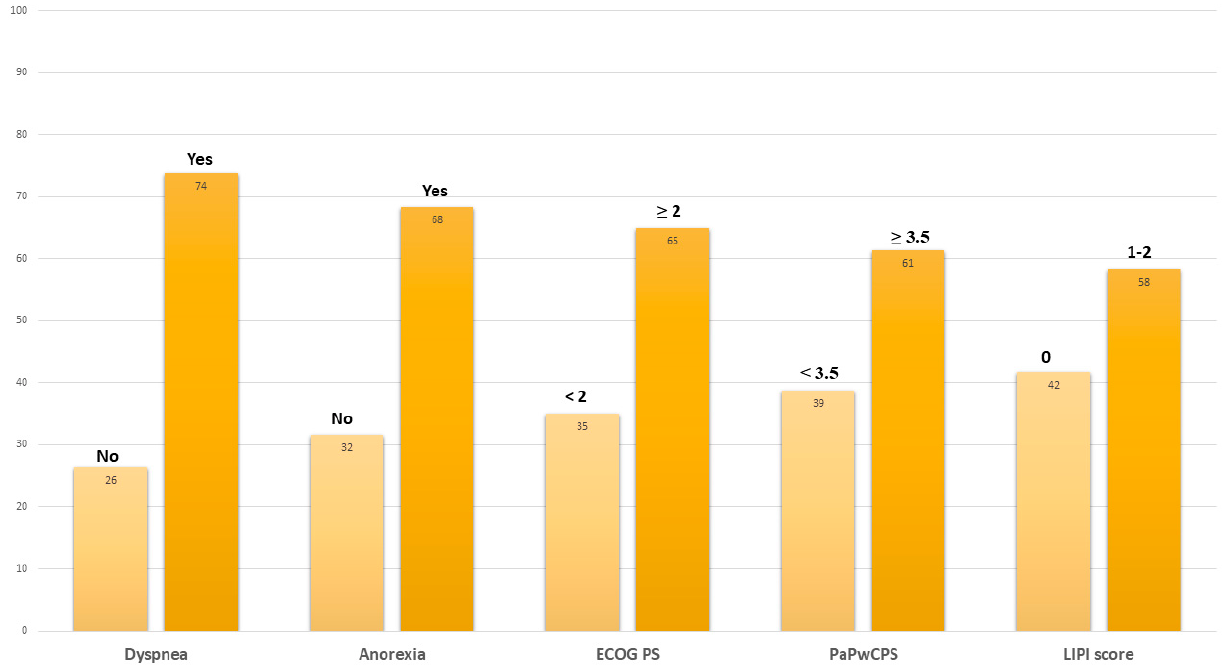
Figure 1. Clinical characteristics registered at last immunotherapy cycle. Abbreviations: ECOG PS, Eastern Cooperative Oncology Group performance status; PaPwCPS, Palli-ative prognostic score without clinical prediction of survival; LIPI, lung immune-prognostic index.